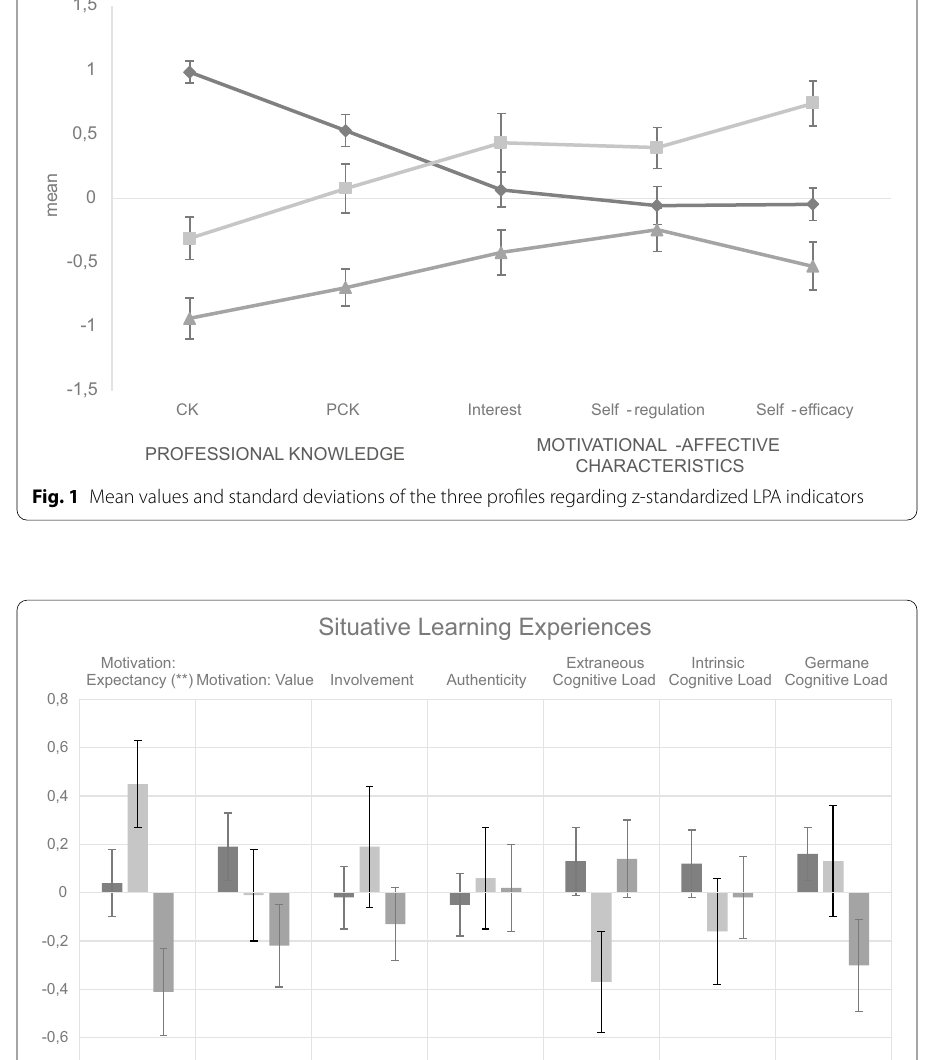
52 pre-service teachers, 34.7%) is =